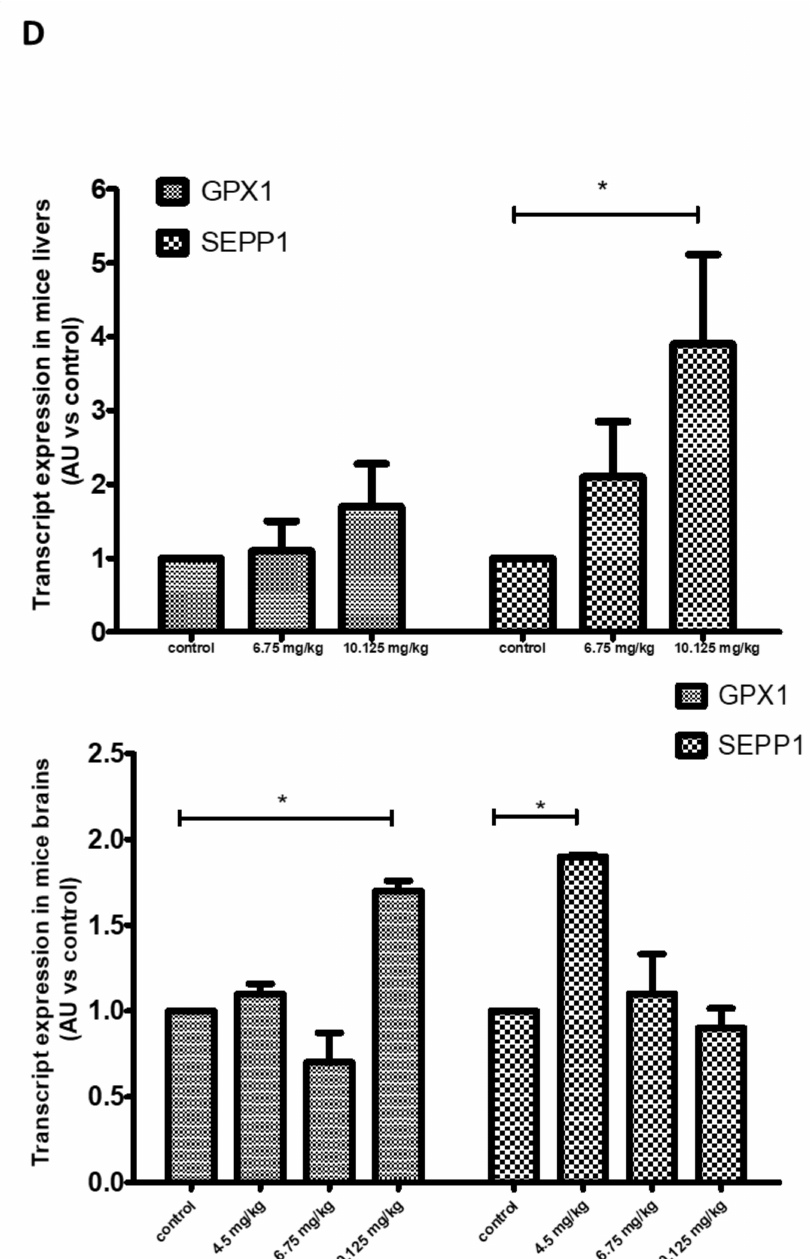
Figure 3. Evaluation of SS toxicity and absorption to evaluate Se status. ( A ) Plasmatic oxidative stress markers of mice receiving SS orally, at different doses (n = 3 mice/concentration group). The dosage of Se was measured in ( B ) plasma and ( C ) in organs via ICP–MS in mice. ( D ) The transcript expression of GPX1 and SEPP1 was evaluated in the brains and livers of mice receiving SS orally. * p < 0.05; ** p < 0.01; *** p < 0.005, and $ p <